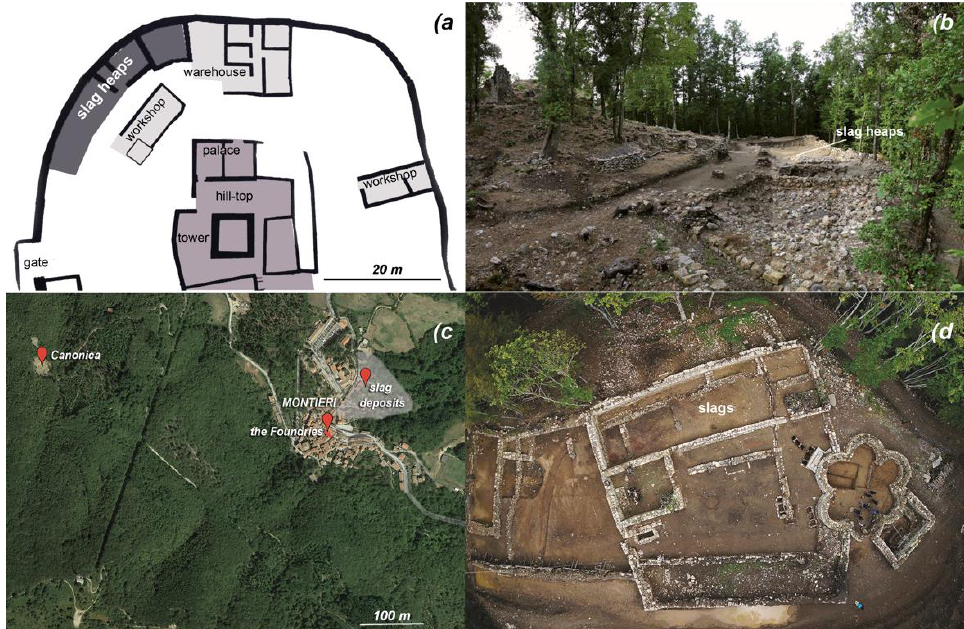
Figure 2. Topographic maps and views of investigated sites: ( a , b ) Cugnano; ( c ) Montieri; ( d ) Montieri, Canonica site.